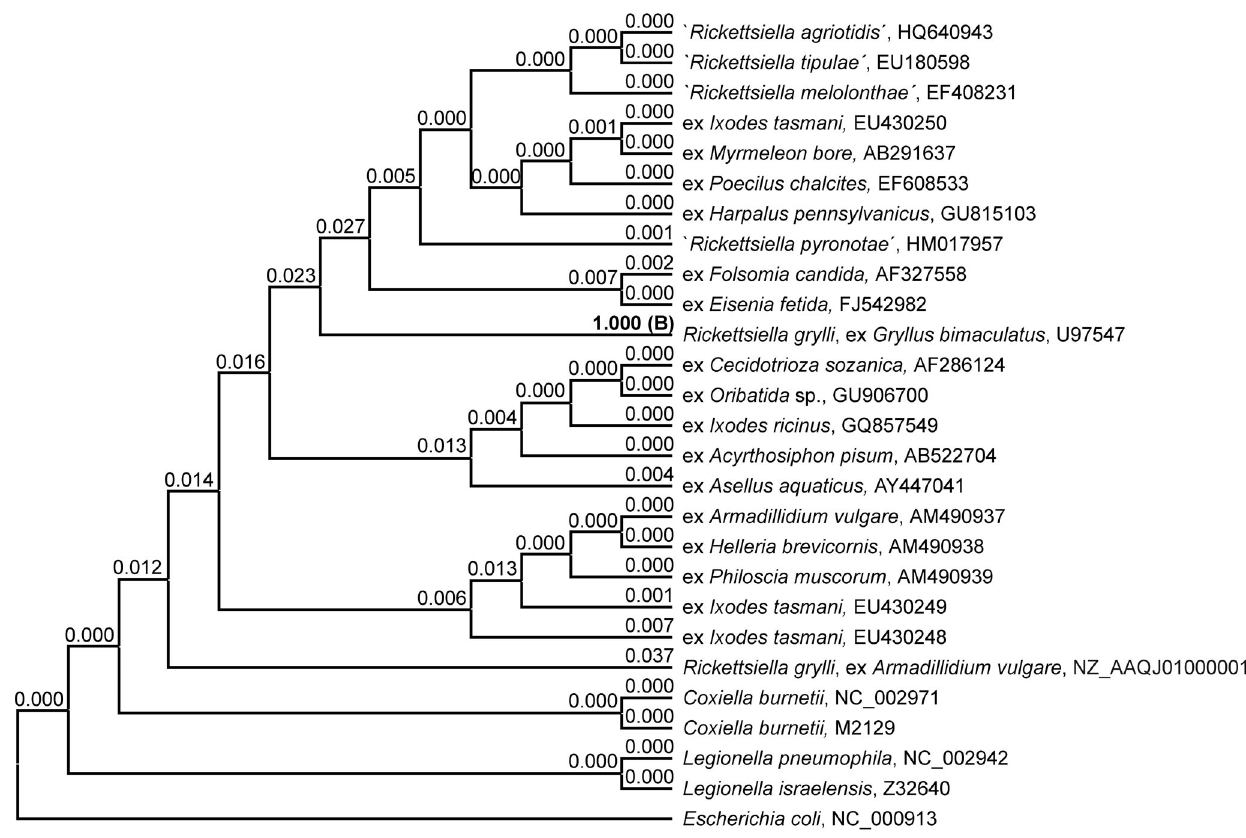
Figure 2. Significance testing evaluating the 16 S rRNA gene based taxonomic assignment of ‘ Rickettsiellaixodidis ’. Cladogram presenting the backbone tree topology generated by pruning off the terminal ‘ Rickettsiella ixodidis ’ branch from the 16 S rRNA gene based ML phylogeny of Figure 1. Terminal branches are labelled by genus and species, pathotype and/or original host designations as well as GenBank accession numbers. A set of 51 candidate topologies to be evaluated by the 1sKH test was generated by re-grafting the ‘ R. ixodidis ’ branch to any of the 51 branches of the backbone topology. Numbers on branches indicate the p-value attributed by the 1sKH test with respect to the 16 S rRNA gene alignment to the candidate topology that carries ‘ R. ixodidis ’ grafted to the respective branch. Candidate topologies that remain unrejected under application of a 5% significance threshold are indicated by the p-value printed in bold type; ‘‘B’’ designates the most likely tree.